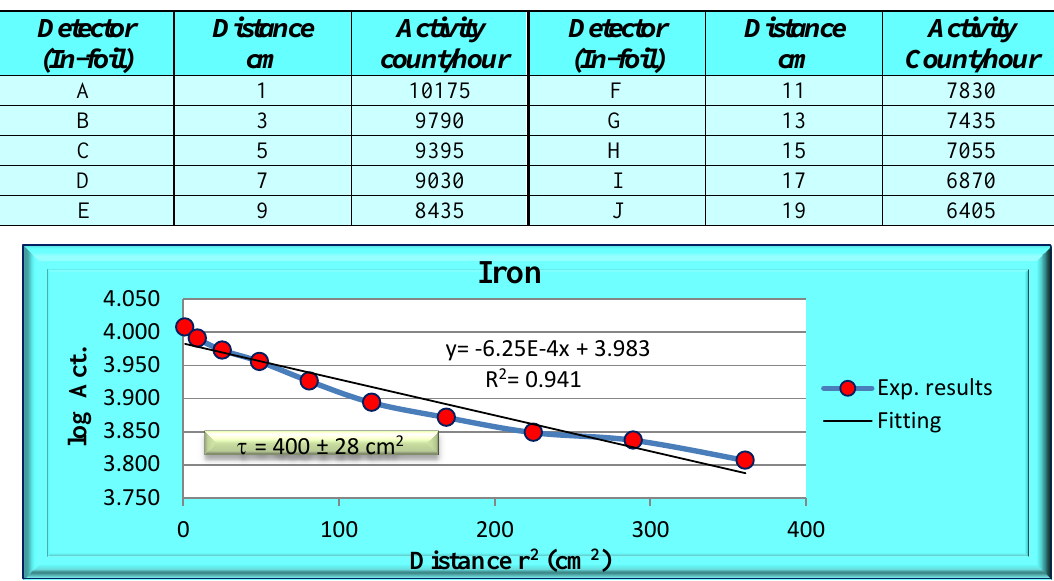
Table 2: Activity measurement of Indium foils in Iron material.